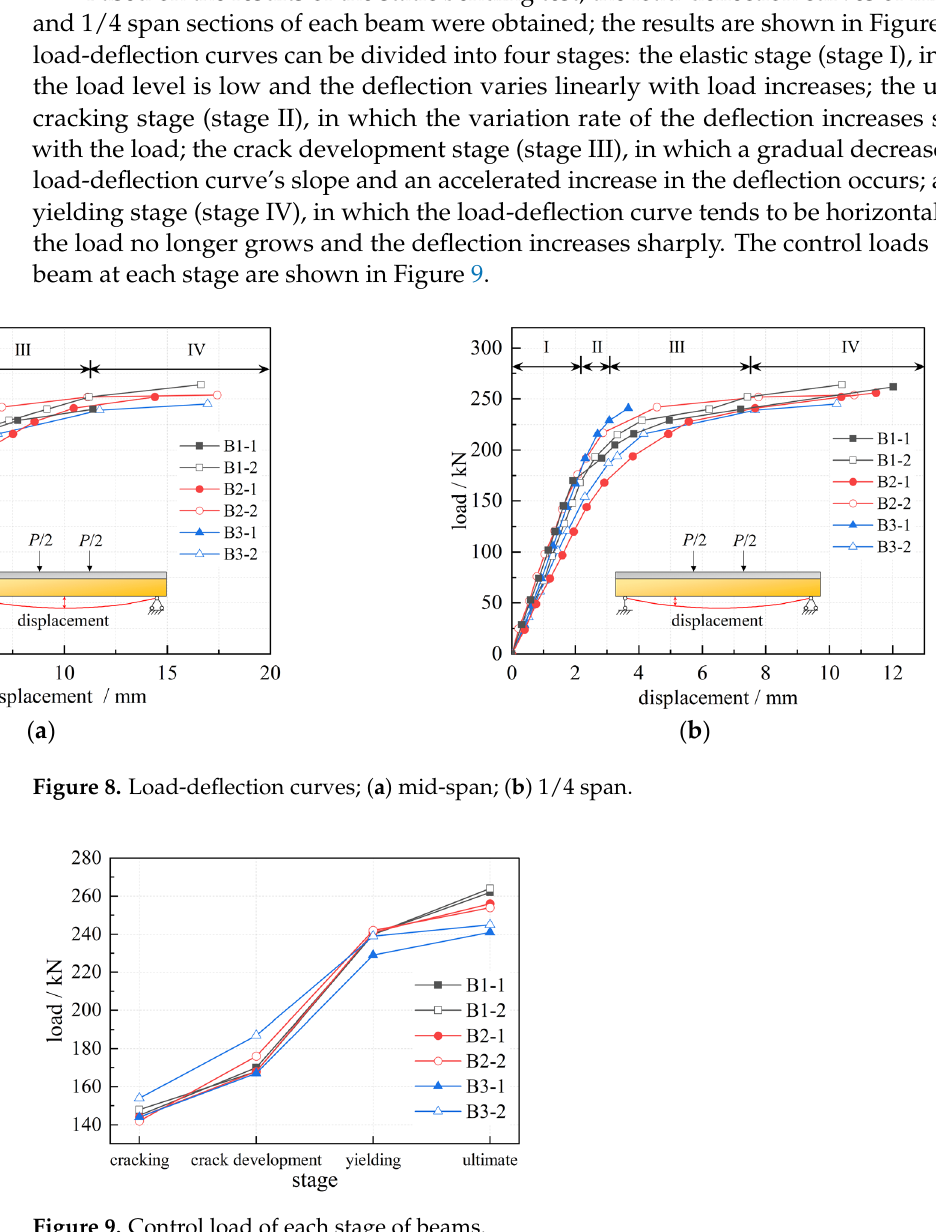
Figure 7. Loading diagram of bending test.